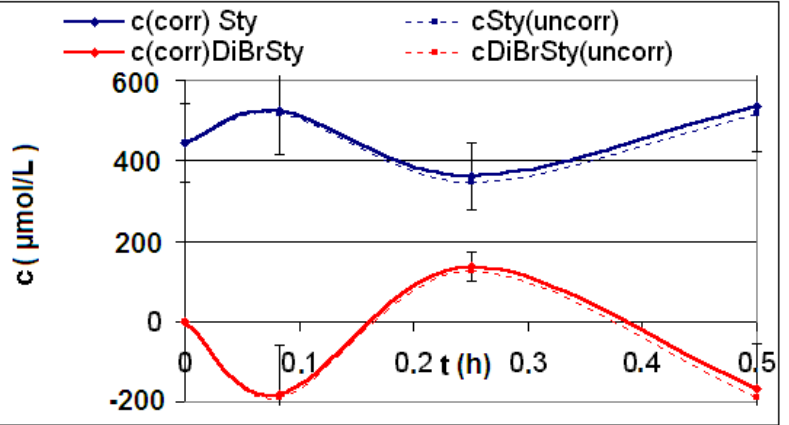
( t ) /c ( t ) corr uncorr